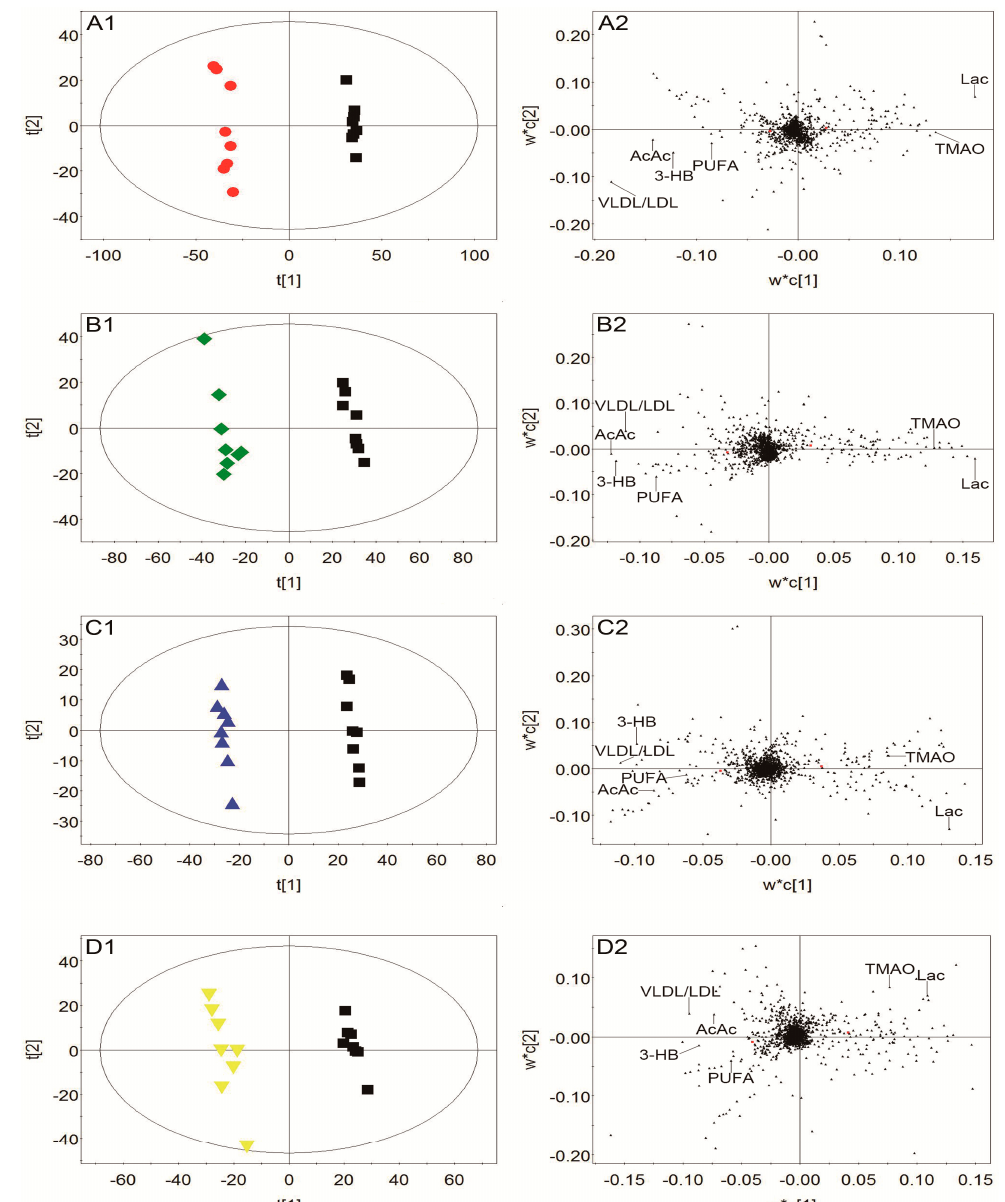
Figure 7. Score plots and loading plots of PLS-DA from plasma: Score plot ( A1 ) and loading plot ( A2 ) of the model and control groups, score plot ( B1 ) and loading plot ( B2 ) of the model and nimodipine groups, score plot ( C1 ) and loading plot ( C2 ) of the model and H-TCNDS groups, and score plot ( D1 ) and loading plot ( D2 ) of the model and L-TCNDS groups. (cid:8) Control group; (cid:4) Model group;